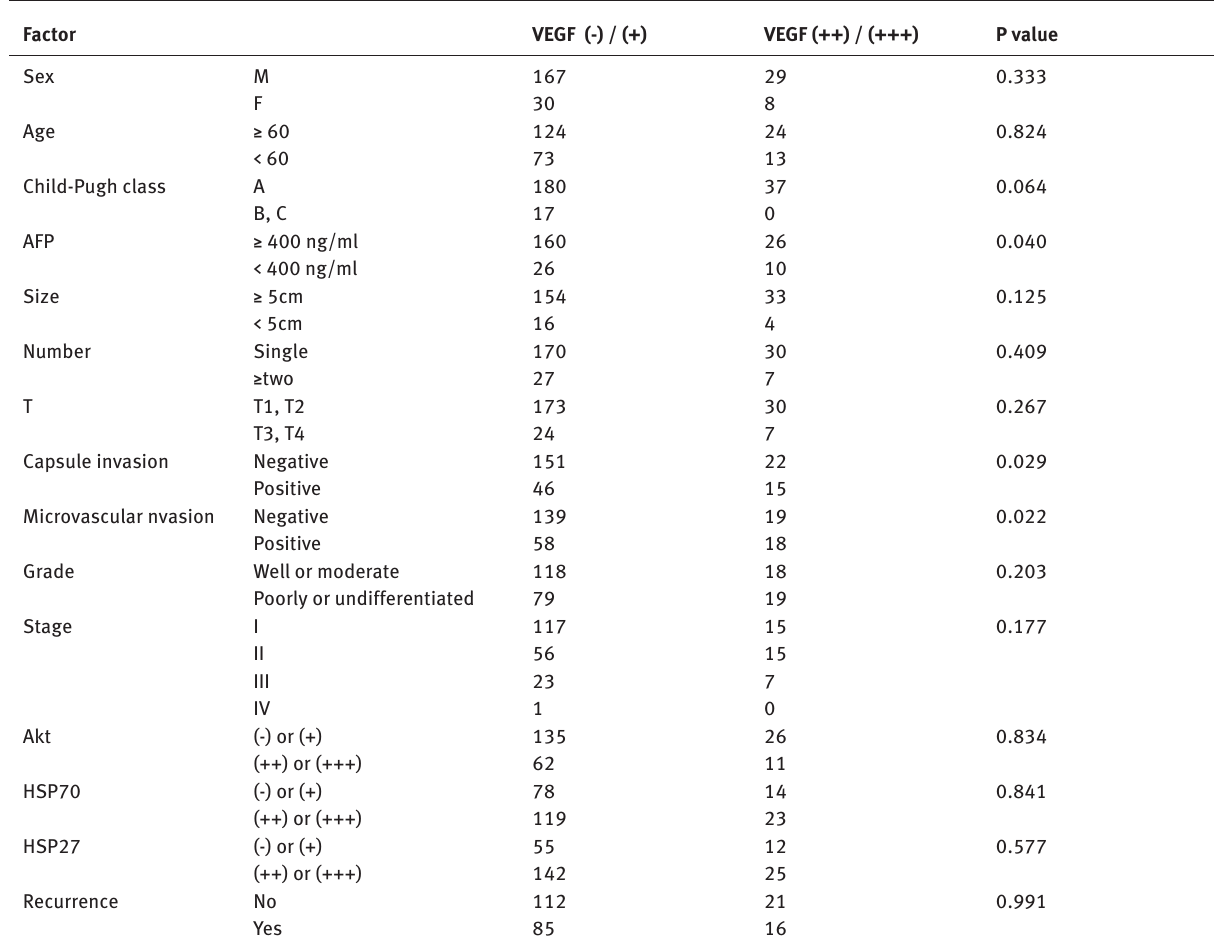
Table 5: Comparison of clinicopathological and immunohistochemical results according to VEGF expression